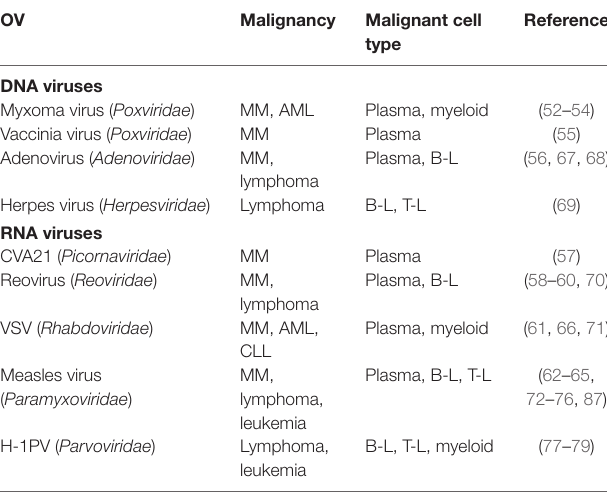
tABLe 1 | Oncolytic viruses (Ovs) targeting hematological malignancies: preclinical